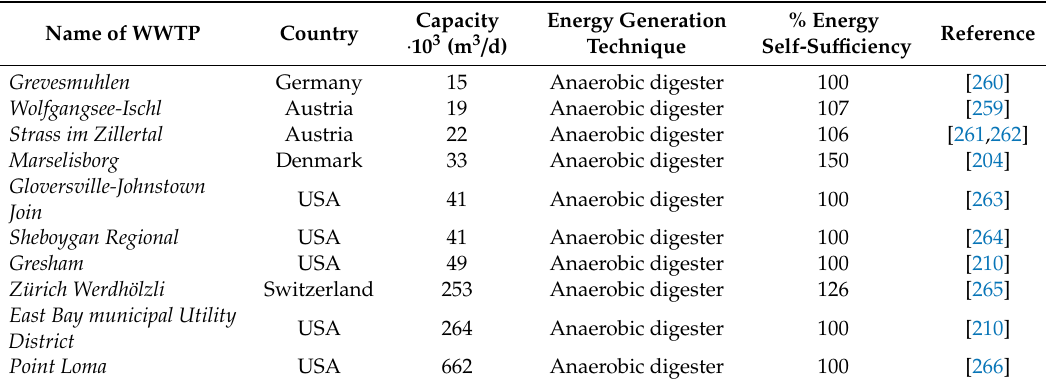
Table 12. Energy self-su ffi cient WWTPs. Adapted from (Gu et al.,